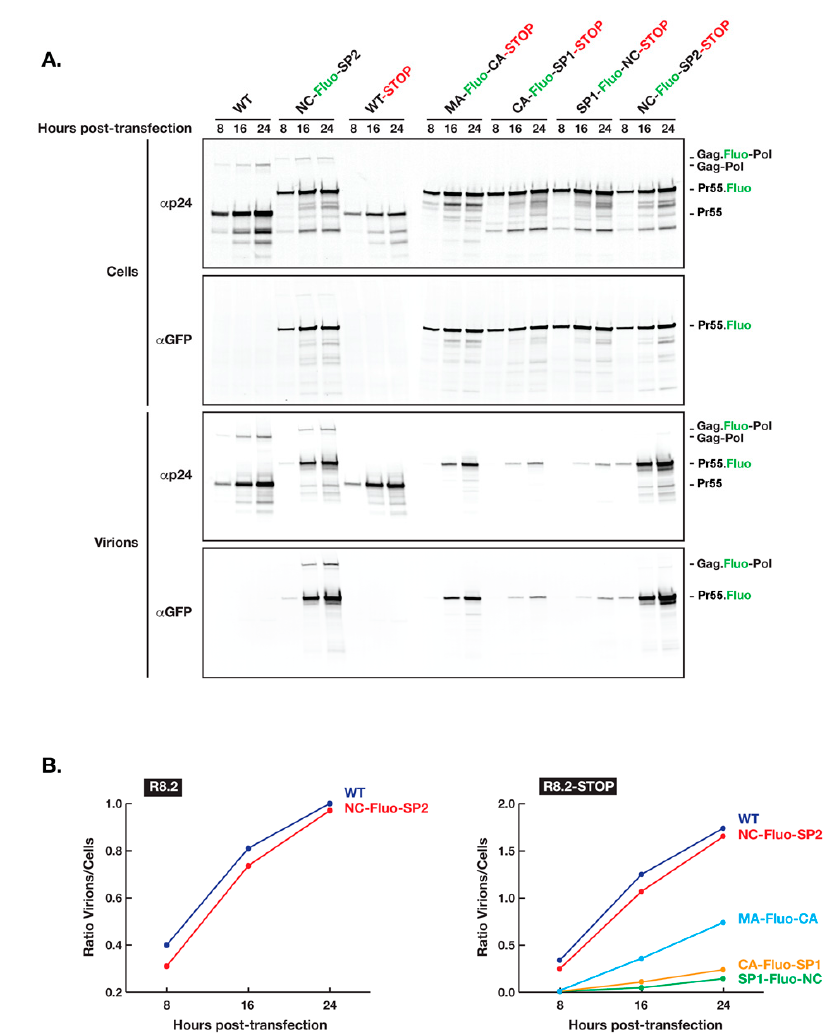
Figure 2. Kinetics of HIV R8.2:Gag–Fluo virion release. ( A ) The expression in 293T cells of Gag and Gag–Pol proteins are shown by R8.2 PR Δ D25N and R8.2:Gag(NC–Fluo-SP2) PR Δ D25N while solely